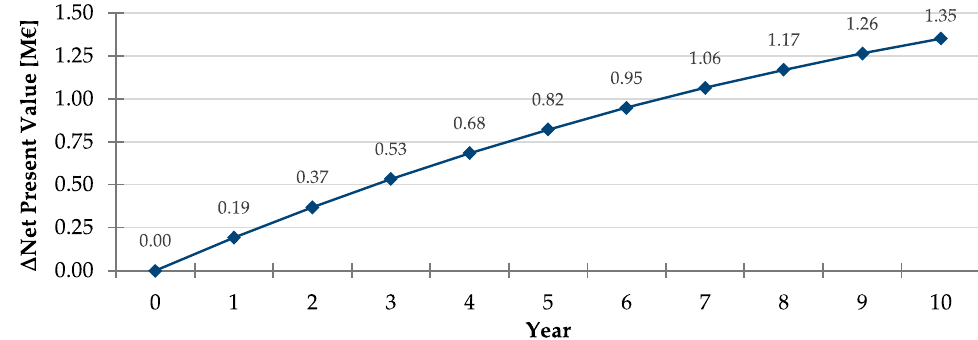
Figure 9. Influence on net present values (NPV) of 5G compared to 4G (only operational costs and benefits).